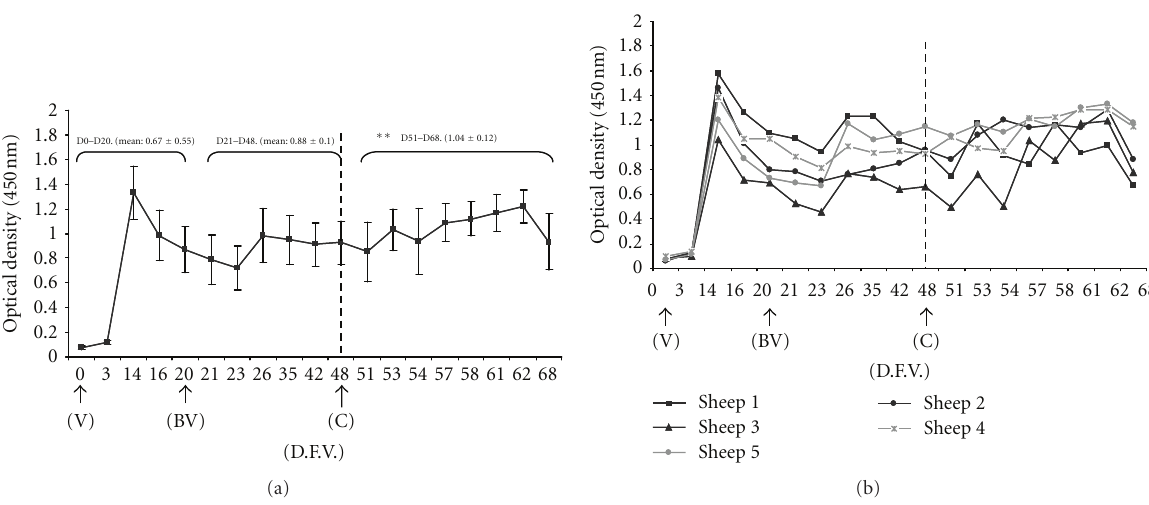
Figure 1: (a) Antibody response in serum samples (mean optical density ± SD) measured by ELISA during the experiment. The threshold below which a response was considered negative was defined as 15% of the positive control optical density. Thus, samples with an optical density > 0.252 were considered positive. The mean value after boost vaccination was significantly di ff erent from that after challenge ( ∗∗ P ≤ 0.05; Mann-Whitney U test for nonparametric distributions). (b) Individual measurements of antibody response. Abbreviations: V, day of first vaccination; DFV, day after first vaccination; BV, day of boost vaccination; C, day of